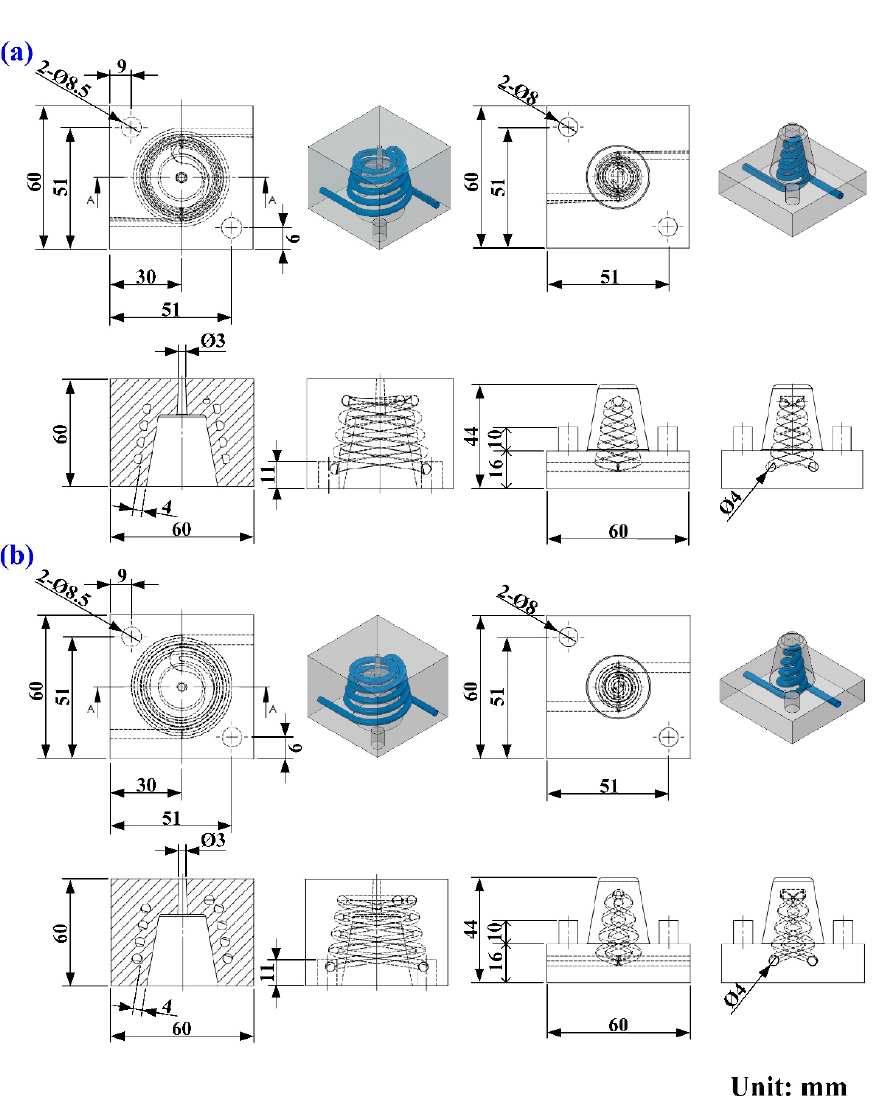
Figure 6. CAD model and dimensions of the wax injection molding tool with ( a ) PCCC and ( b )